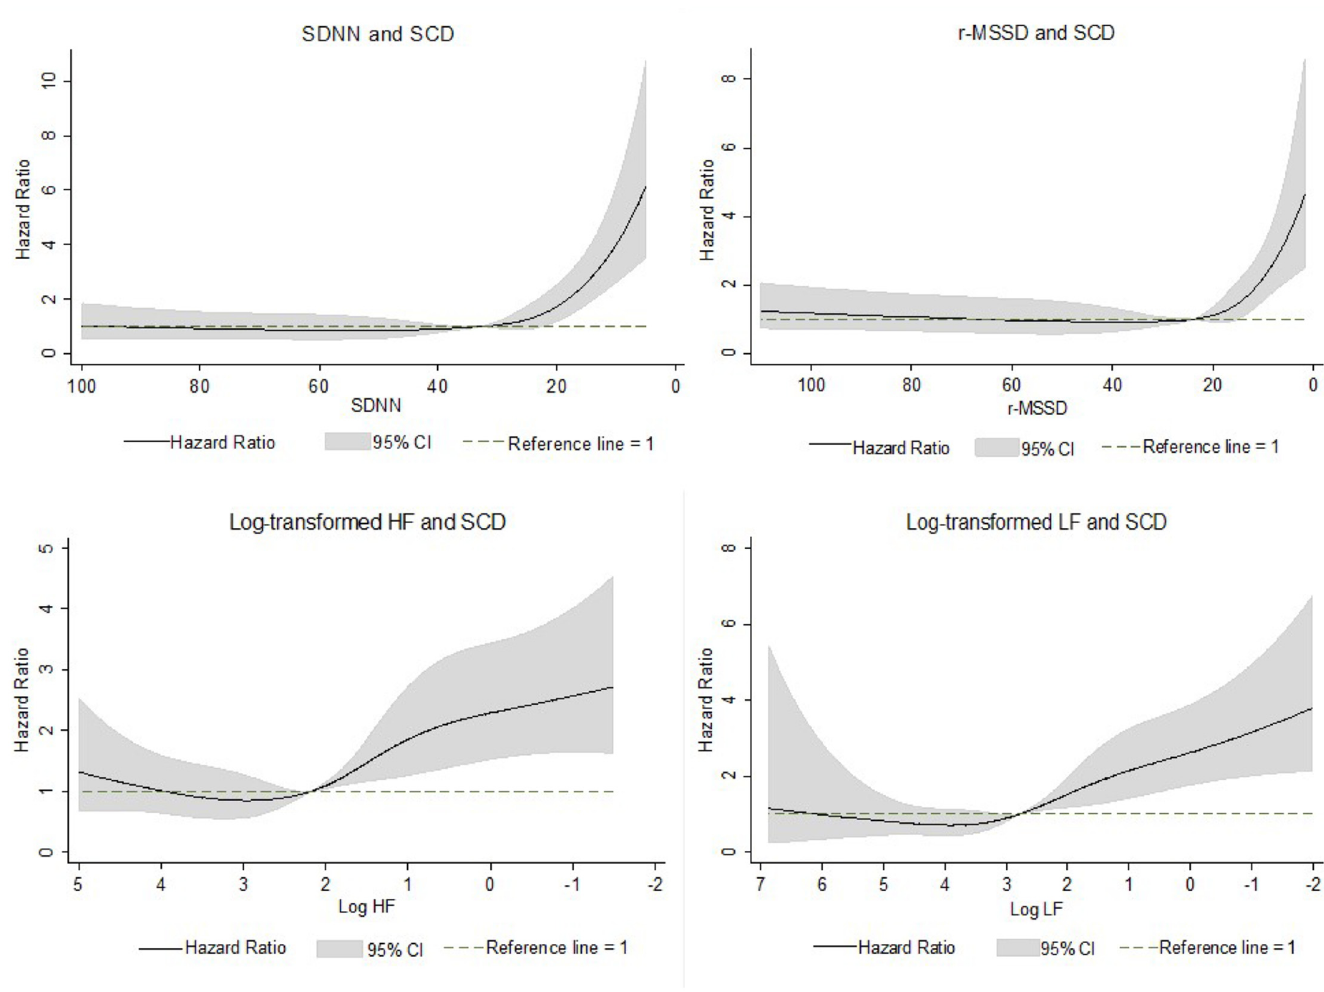
Fig 1. Heart Rate Variability Measures and Sudden Cardiac Death Risk. Association between heart rate variability measures and sudden cardiac death incidence presented as hazard ratios (solid line) and 95% confidence intervals (shaded area). Results from Cox proportional hazards model with heart rate variability measures modeled using restricted cubic splines, adjusted for age, sex, and race. Median value of heart rate variability measures was considered the reference (HR = 1). The x-axis is presented using an inverted